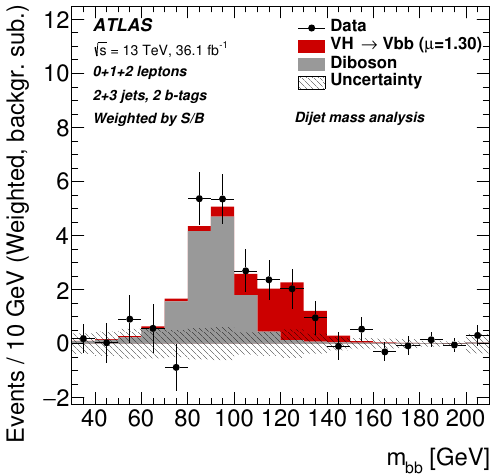
Figure 8 . The distribution of m bb in data after subtraction of all backgrounds except for the WZ and ZZ diboson processes, as obtained with the dijet-mass analysis. The contributions from all lepton channels, p V intervals and number-of-jets categories are summed weighted by their respective T value of the ratio of (cid:12)tted Higgs boson signal and background. The expected contribution of the associated WH and ZH production of a SM Higgs boson with m H = 125 GeV is shown scaled by the measured combined signal strength ( (cid:22) = 1 : 30). The size of the combined statistical and systematic uncertainty for the (cid:12)tted background is indicated by the hatched band.